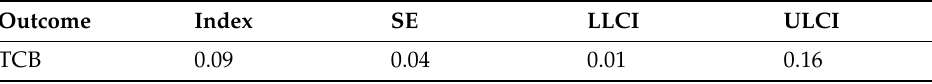
Table 6. Index of moderated mediation.